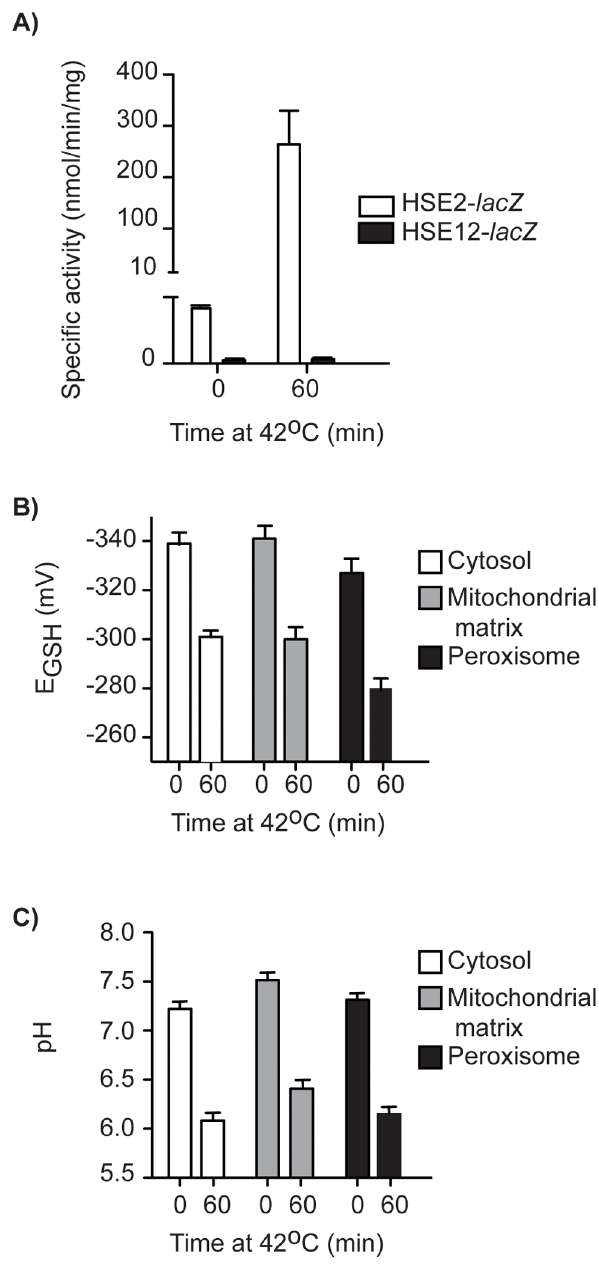
Figure 6. Effect of heat shock on compartmental E GSH and pH. A) Wild-type cells with the HSE2-lacZ (heat-shock response induction reporter) construct were pregrown in SC URA (48 h; 30 u C; 600 rpm) and then inoculated in SC URA (A 600 =0.001) and grown (25 u C; 600 rpm) until exponential phase (A 600 = , 0.5). Cells were then shifted to 42 u C for 60 min and harvested. b -galactosidase and total protein (Bradford) assays were carried out on cell pellets and specific activity determined. B-C) Cells were pregrown in SC URA (48 h; 30 u C; 600 rpm), inoculated